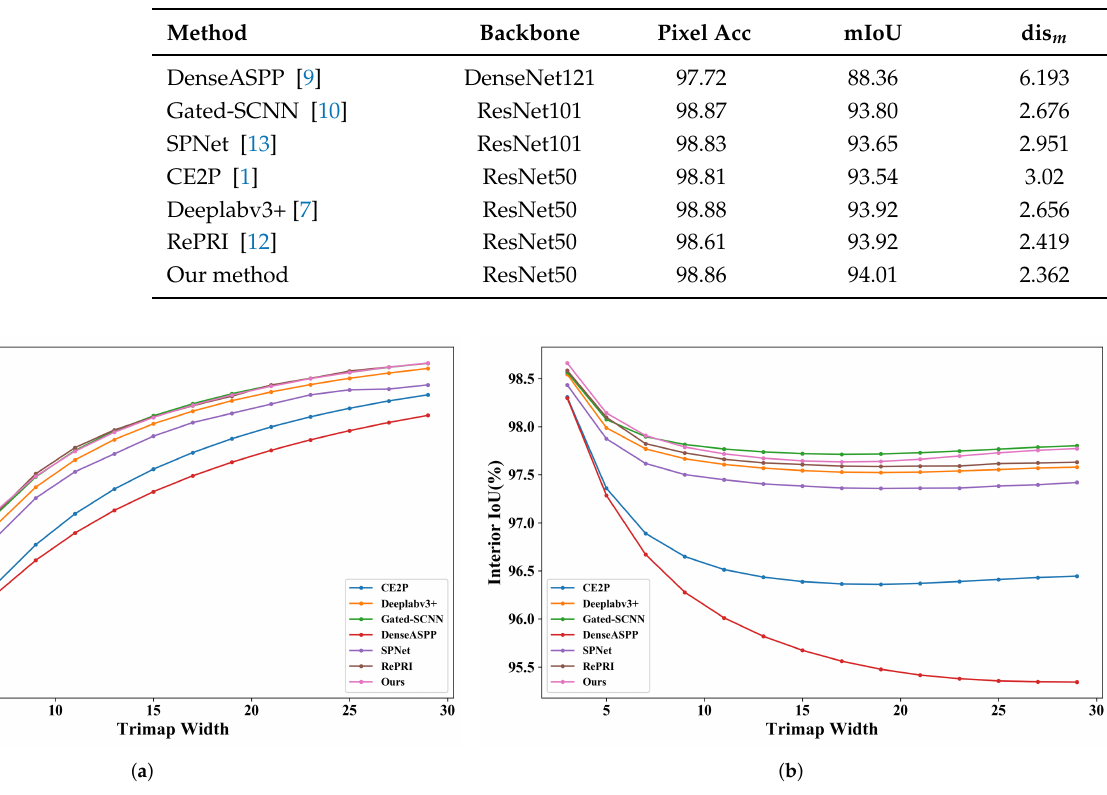
Figure 8. Error analysis on test set. Boundary IoU ( a ) and Interior IoU ( b ) have different trimap